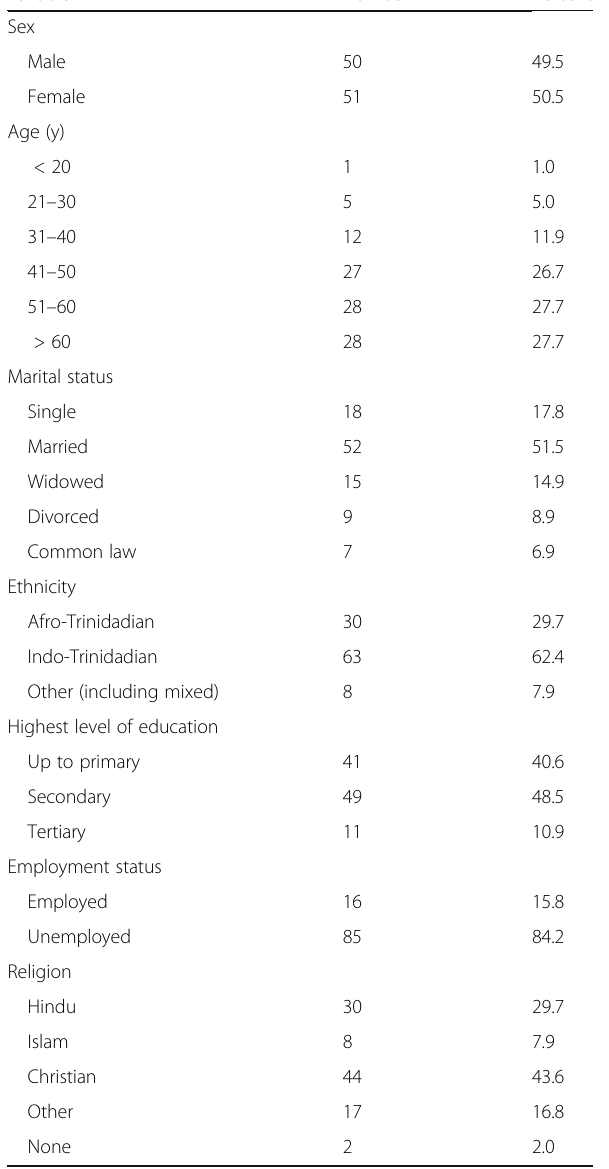
Table 1 Sociodemographic characteristics of the patients Table 2 Demographic characteristics of CAM users